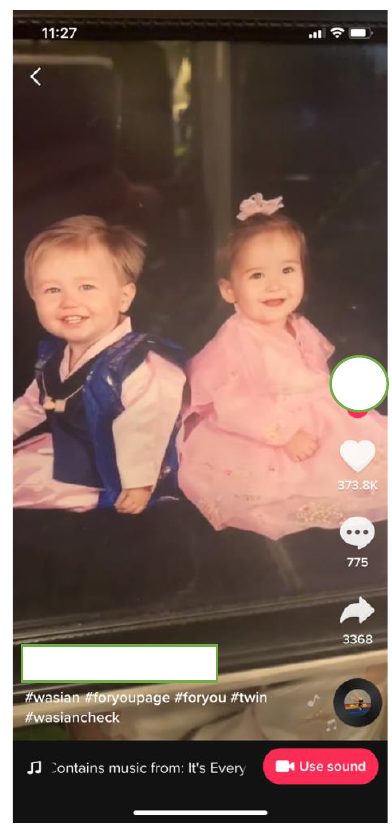
Figure 9. An Example of Wearing ‘Asian’ Dress .